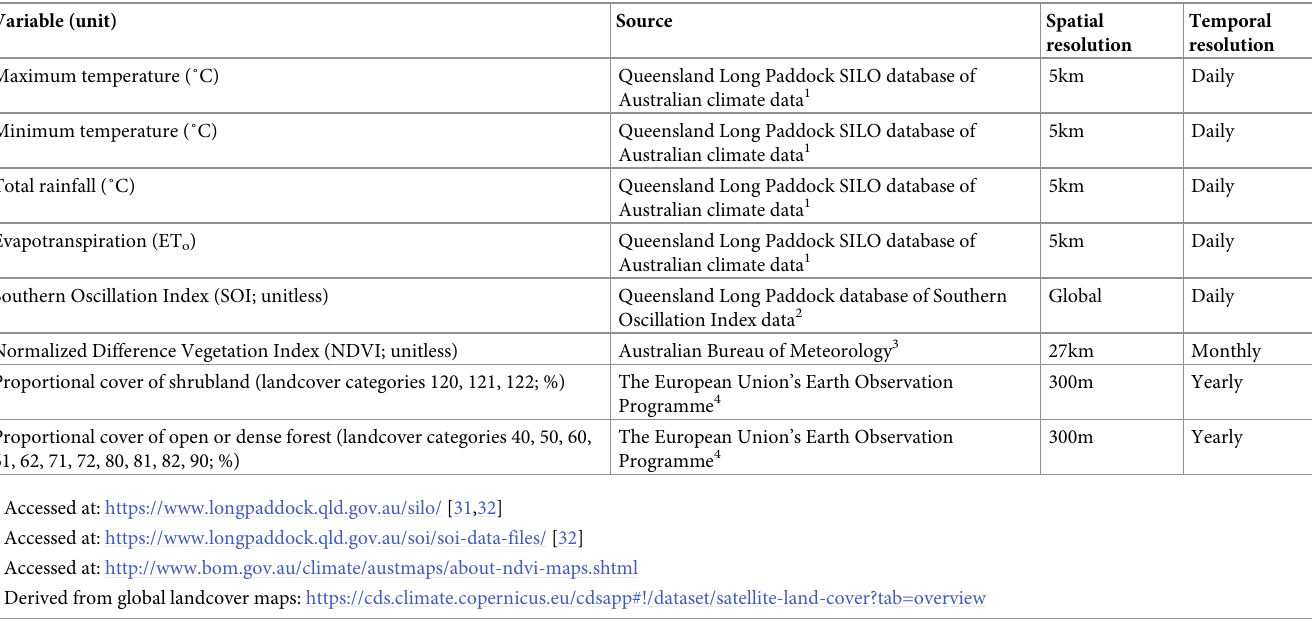
Table 1. Sources, spatial and temporal resolutions of covariates used to calculate predictors. Variable (unit) Source Spatial